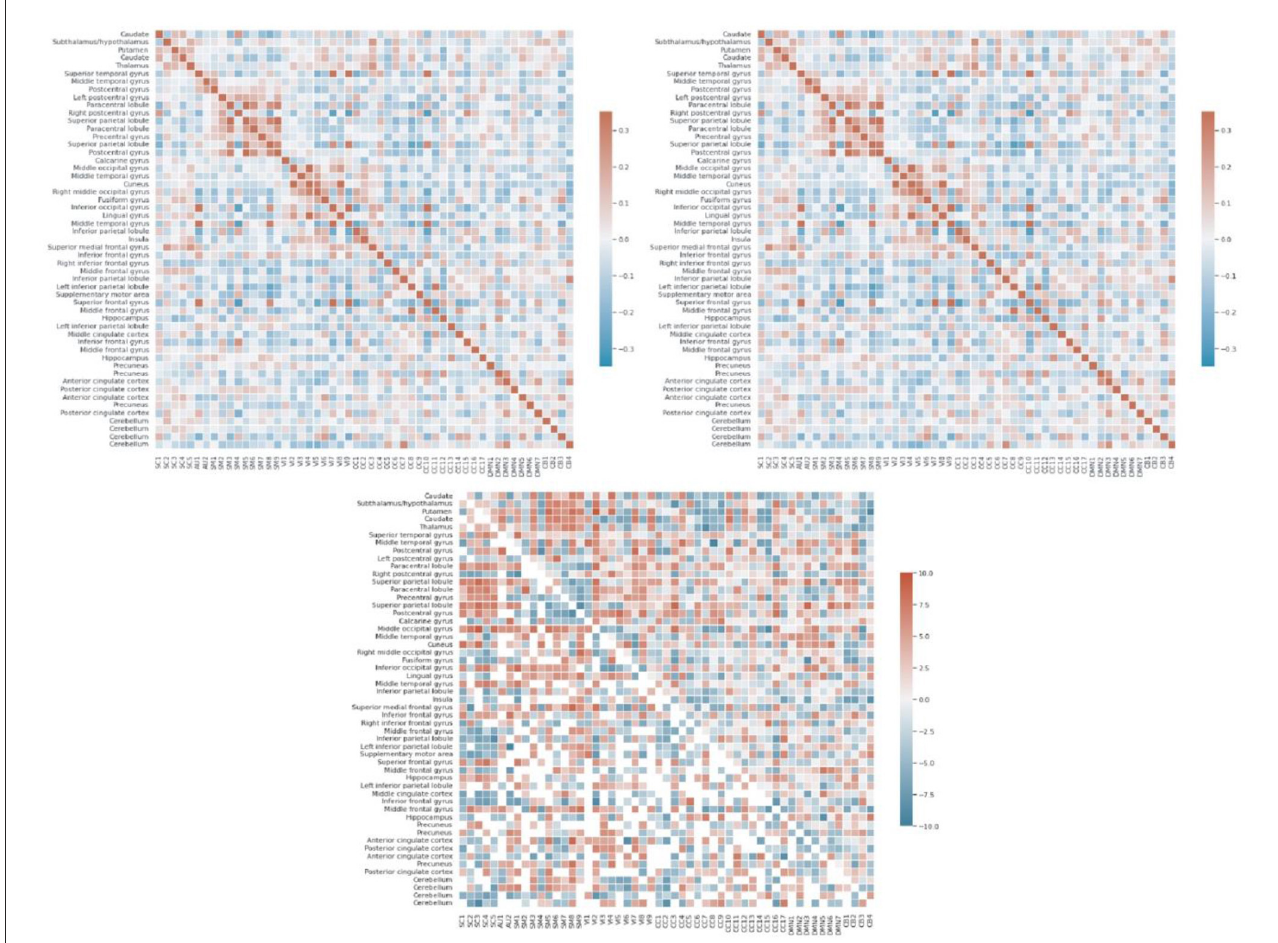
FIGURE7 Each of FNCs illustrates correlation between all 53 components grouped into 7 sub-domains including default mode network (DMN), visual (VI), auditory (AU), cognitive control (CC), subcortical (SC), sensori-motor (SM), and cerebellar (CB) for controls (top left) , schizophrenia patients (top right) , and thresholded 2 sample T -test for HC-SZ (bottom)